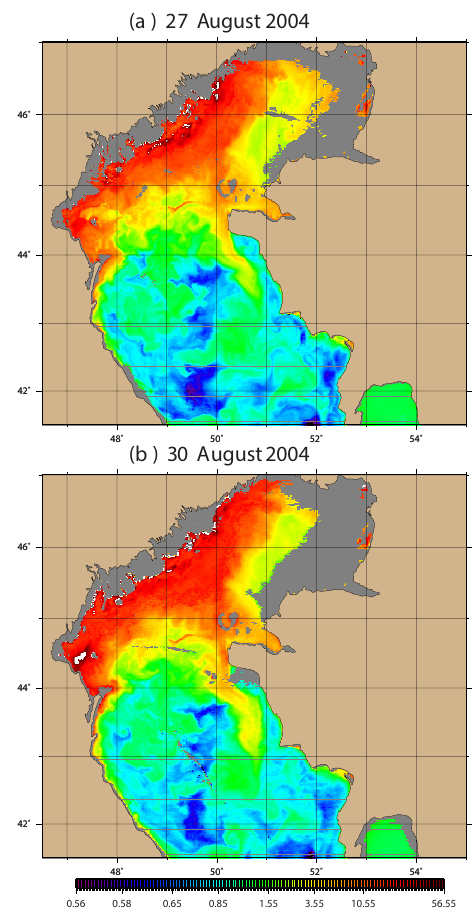
Figure 7. Chlorophyll concentration (in mg m − 3 ) on (a) 27 Au- gust 2004 and (b) 30 August 2004. The chlorophyll concentration contours are plotted with different colours and intervals for a better visualization of the